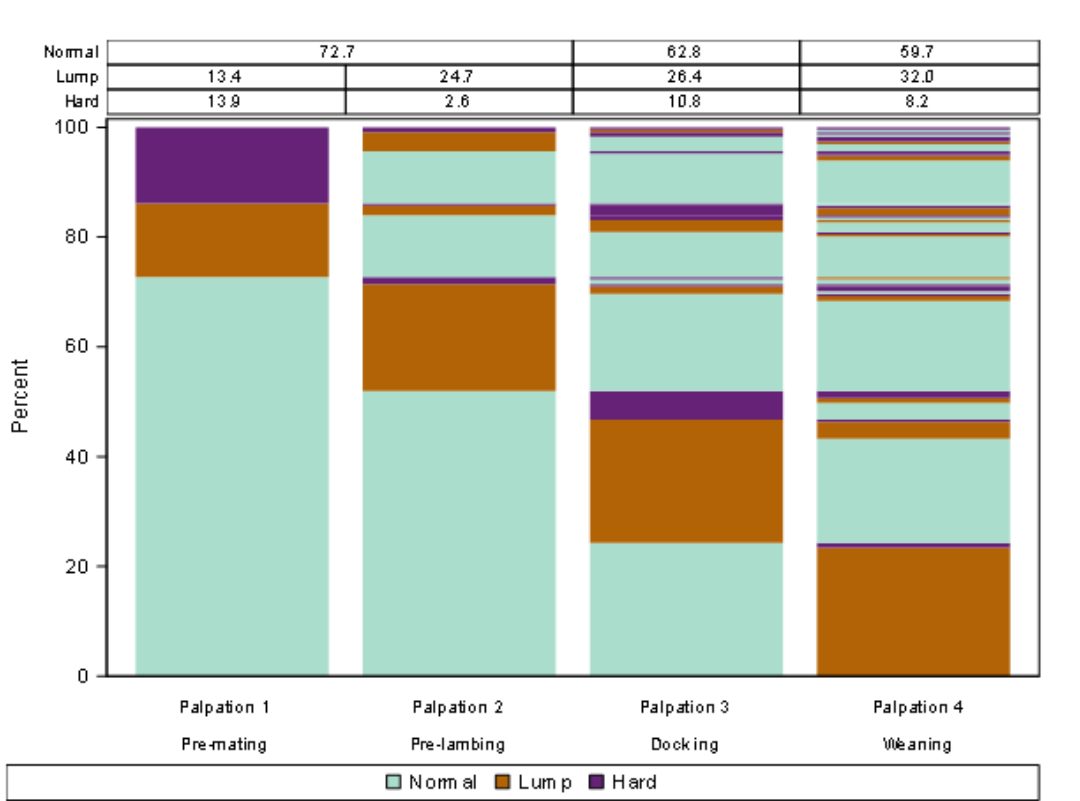
Figure A1. Lasagna plot of palpable udder half defects (hard, lump and normal) from non-dairy Romney ewes identified during udder examination events occurring at key management times (pre-mating, pre-lambing, docking, and weaning; Study A). Lasagna plot of 231 udder halves in year 2017, excluding udder halves observed with no udder defect on all occasions. Note: Within each plot, each bar shows a different udder half scoring event (i.e., time) while the different colours within each bar represent the defect categories. The data in the table at the top of each plot designates the percentage (%) of each udder half defect category at each event, which corresponds to the percentage of each colour at each event. Change in defect category over time of each udder half can be tracked by following longitudinal transitions across the udder scoring events of stacked bars.